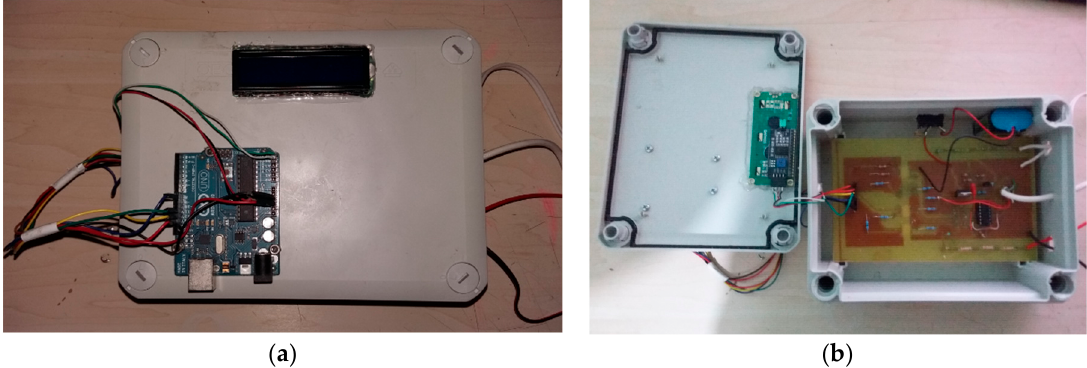
Figure 7. Experimental system (details): Optical isolation unit, SBM1, SBM2, electric loads, measuring instrumentation (voltmeter, ammeter).